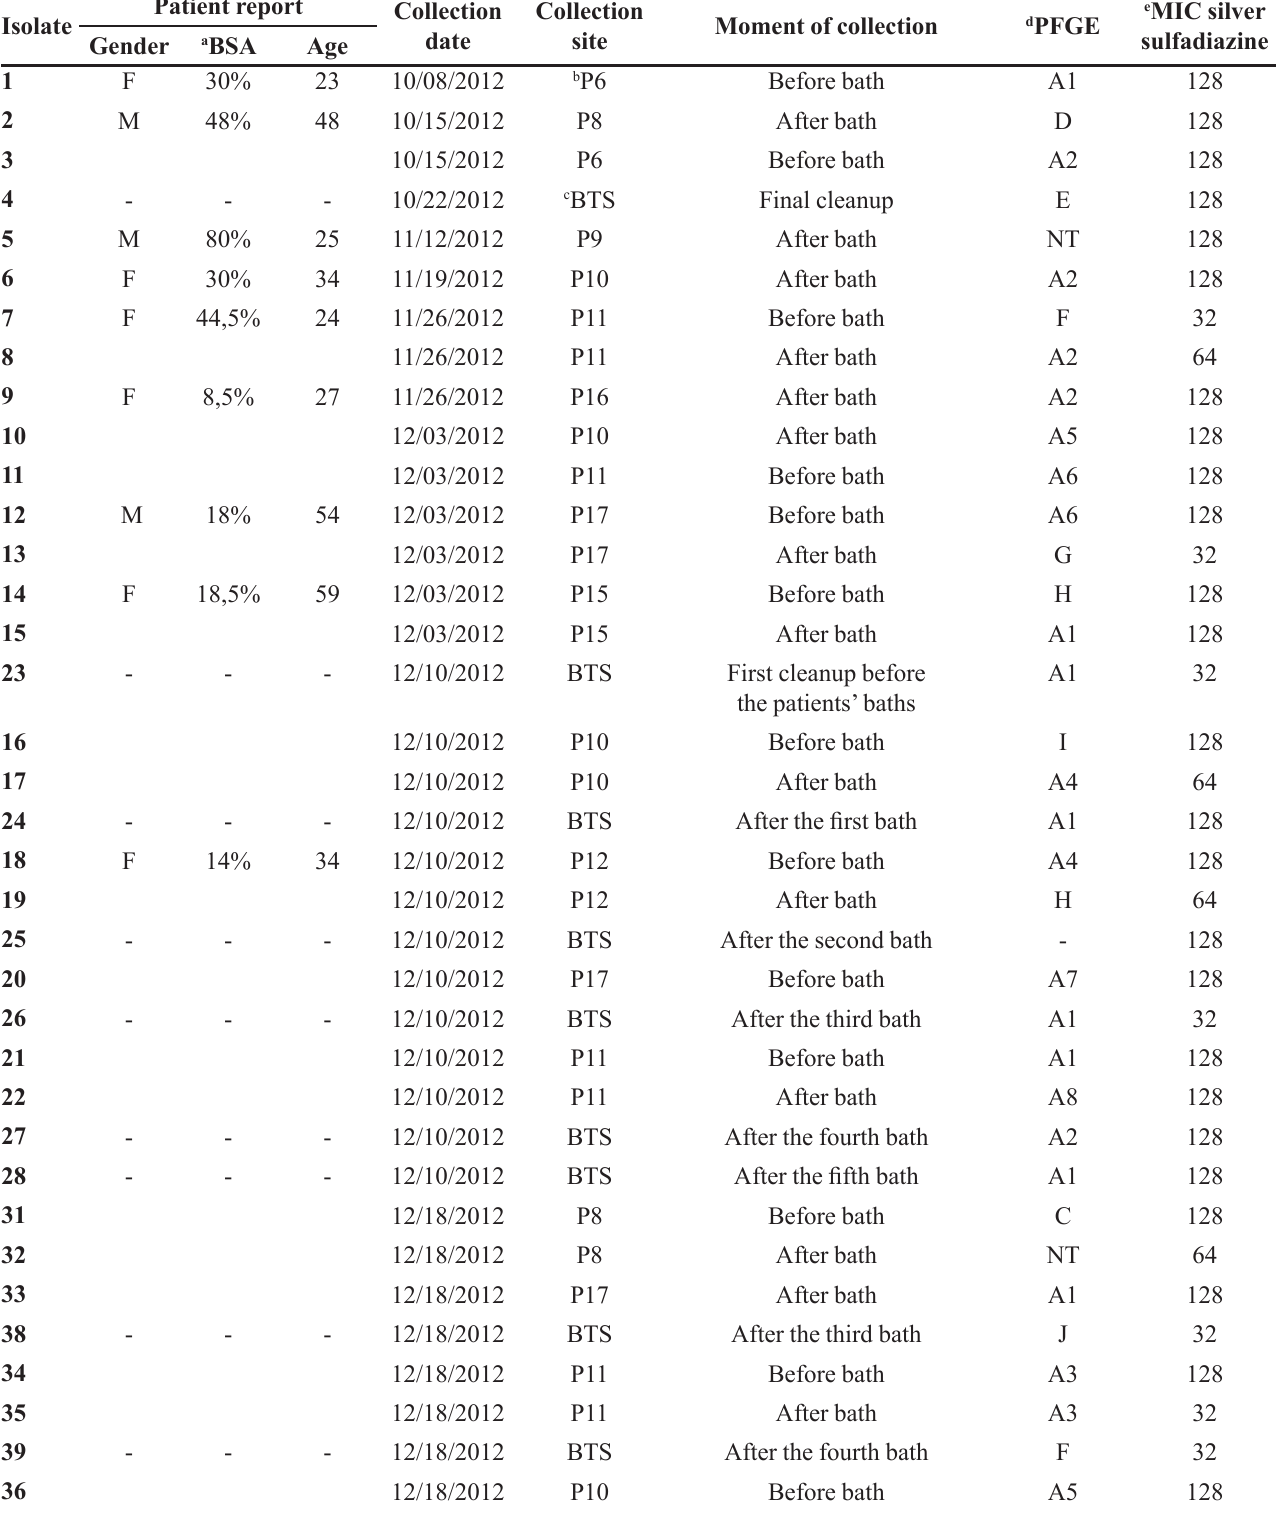
TABLE I - Characterization of the 37 colonizing Pseudomonas aeruginosa